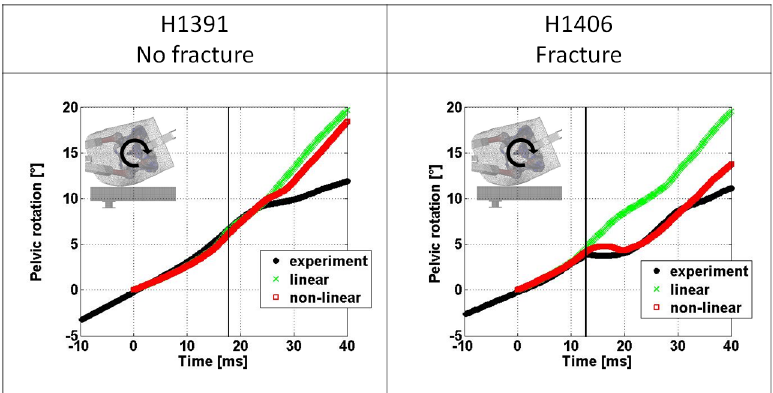
Fig 6. Comparison of pelvic rotation in the coronal plane over time between experimentally and FEM derived results. The vertical lines indicate the time of experimentally measured peak impact force.